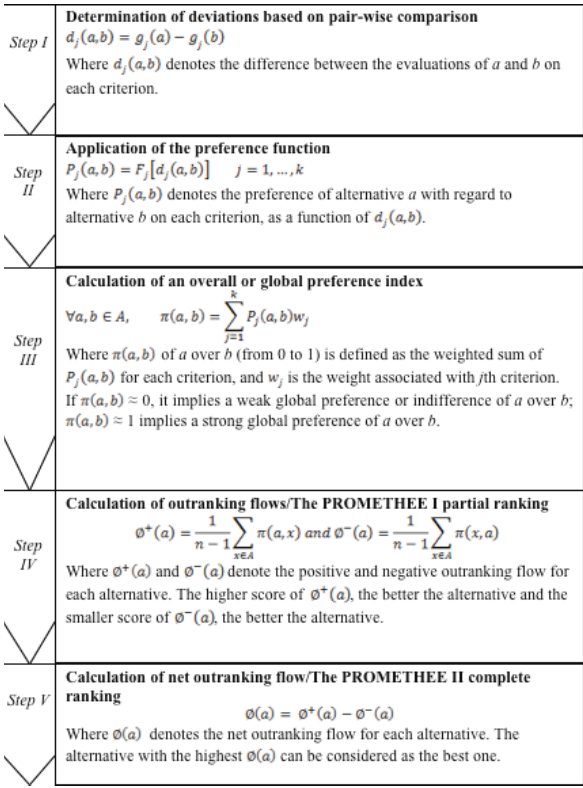
Figure 2: Stepwise procedure of PROMETHEE II method (modified from Behzadian)